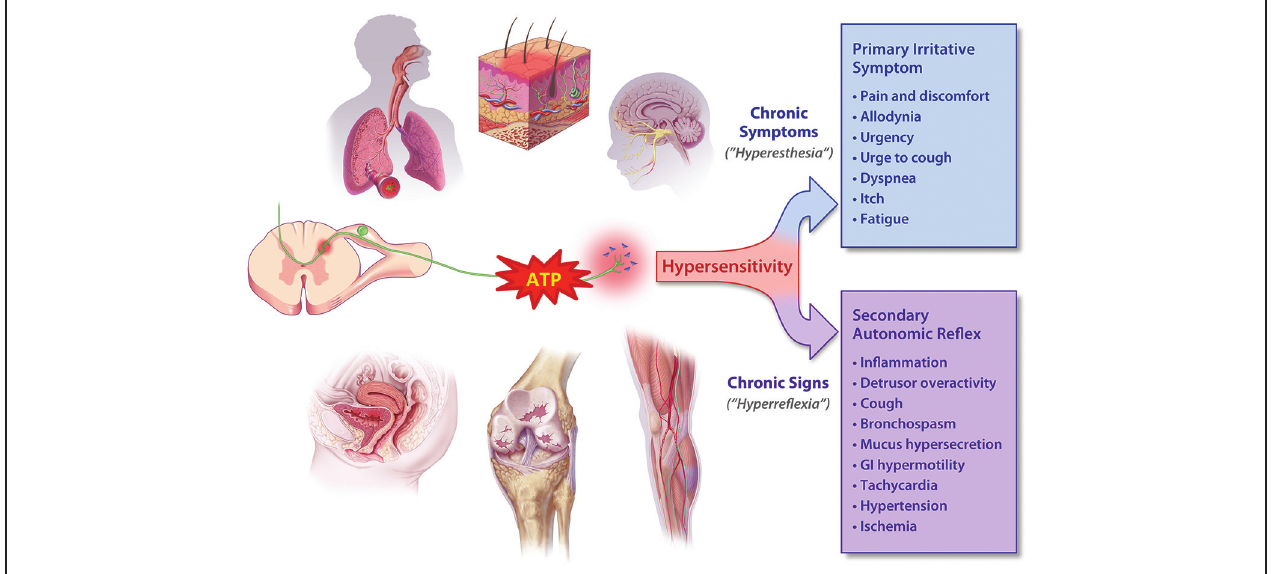
FIGURE 1 | ATP is released in heightened amounts in a variety of somatic and visceral tissue systems and may cause hyperexcitability (“sensitization”) of PANs . Depending on the nature of the affected tissue, the elevated afferent discharge drives the increased perception of irritative